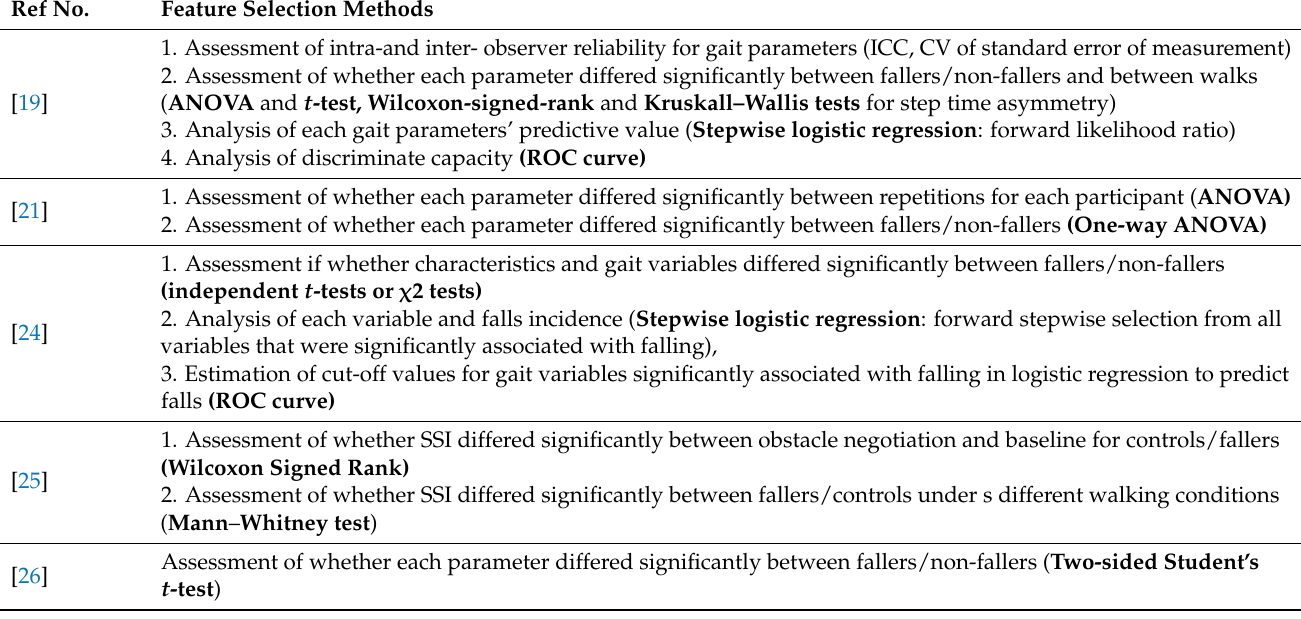
Table A2. Complimentary information for the feature selection methods in Table 4. COG = center of gravity, ICC = Intra-class correlation coefficient, SSQ = Simulator Sickness Questionnaire.